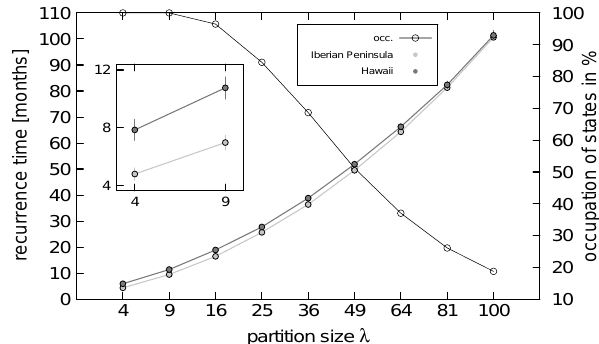
Fig. 8. Recurrence time of the regional climate systems of Hawaii (dark grey) and the Iberian Peninsula (light grey). From partition size λ = 16 full occupation of the states of the transition matrix cannot be